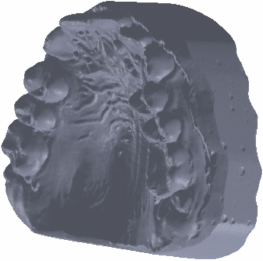
Figure 7. The final virtual solid of the scanned maxillary